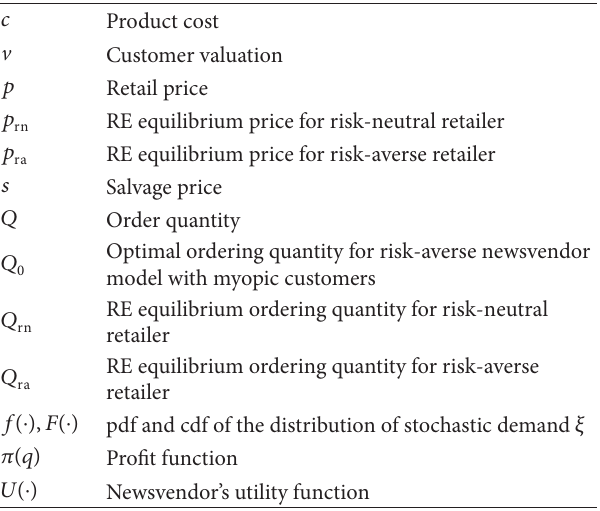
Table 1: Notions used in this